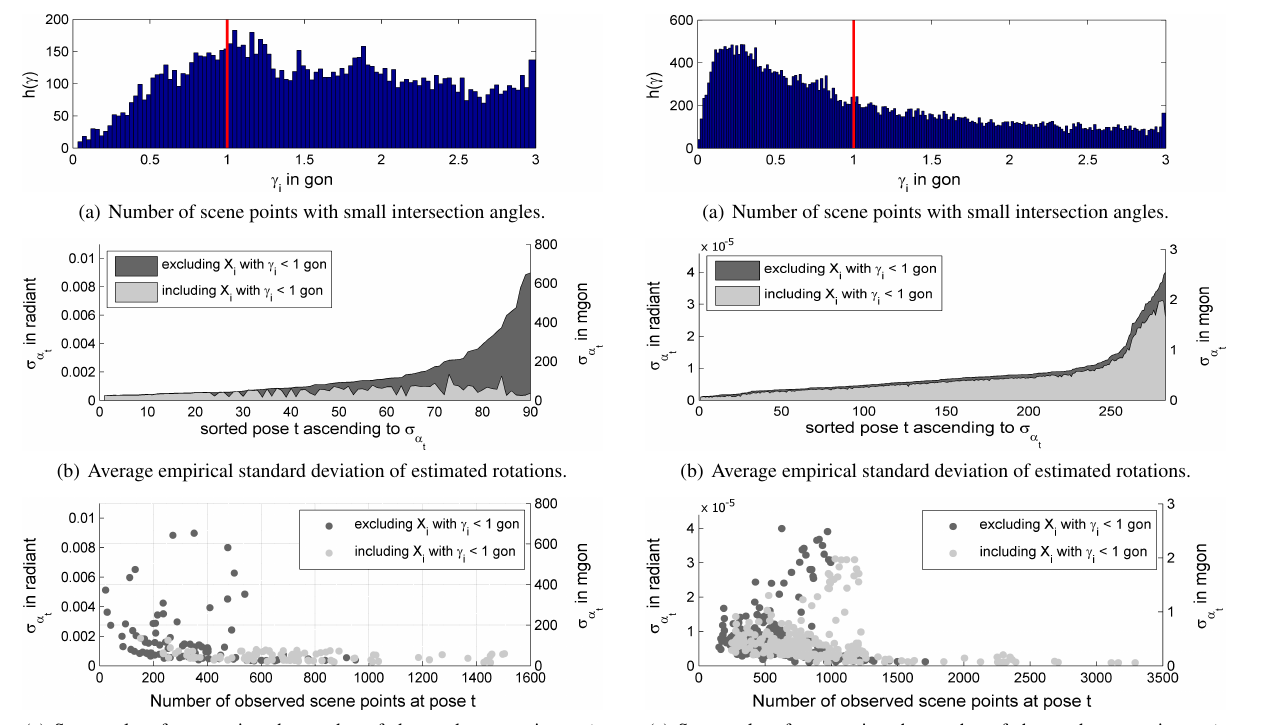
Figure 8: The subplots (a), (b) and (c) show the results of the Figure 7: The histogram in (a) shows the number of scene points investigations explained in Fig.7 on the urban drive in the multi-camera dataset with small intersection angles. The average precision σ α determined by excluding and including t scene points with γ < 1 gon for all poses t = 1 , ..., T is com- pared to each other in (b) and against the number of observed scene points in (c).